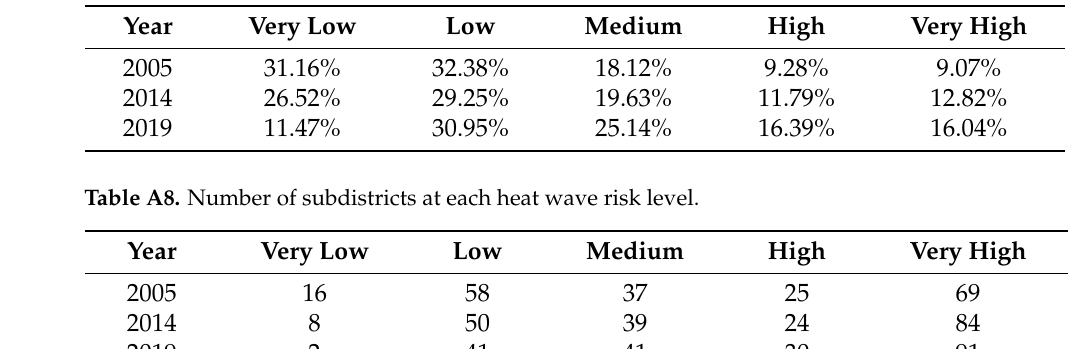
Table A7. Changes in the percentage of the different risk levels from 2005–2019 (%).